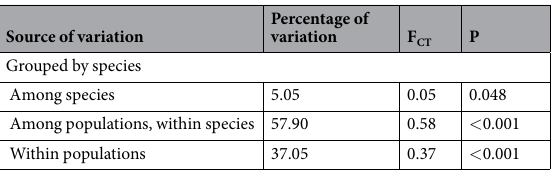
Percentage of variation F CT P